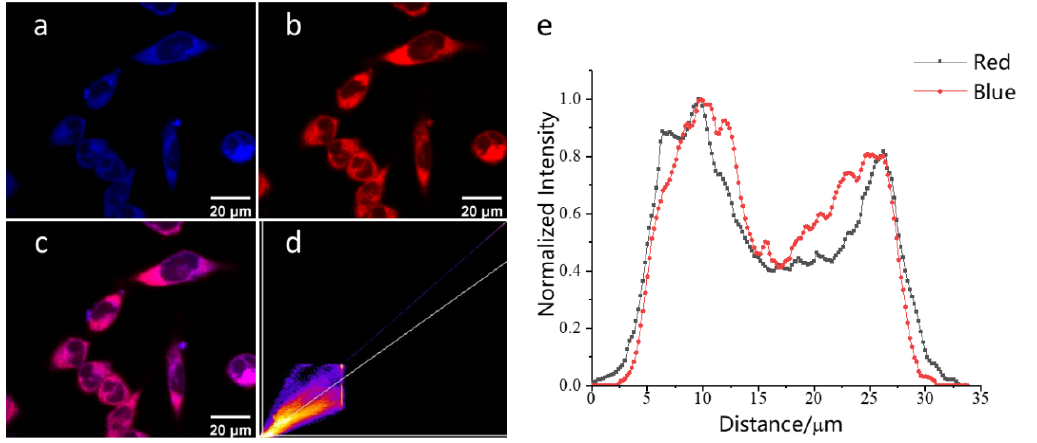
Figure 4. ( a ) Fluorescence images of IPB-RL-1 in SKOV-3 cells (blue channel: 420–520 nm; λ ex : 405 nm). ( b ) Fluorescence images of Mito-Tracker Red CMXRos (red channel: 570–620 nm; λ ex : 561 nm). ( c ) Merged images of ( a , b ). ( d ) Images of co − location (co − location coefficient 0.91). ( e ) Fluorescence intensity of red channel and blue channel changes, respectively (λ ex : 405 nm).